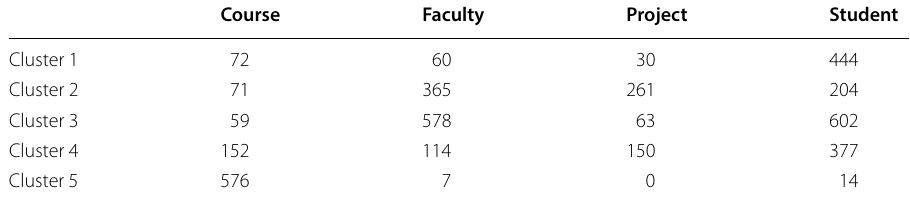
Table 12 The category distribution in clusters generated by Cosine (WebKB, tf-normal) Course Faculty Project